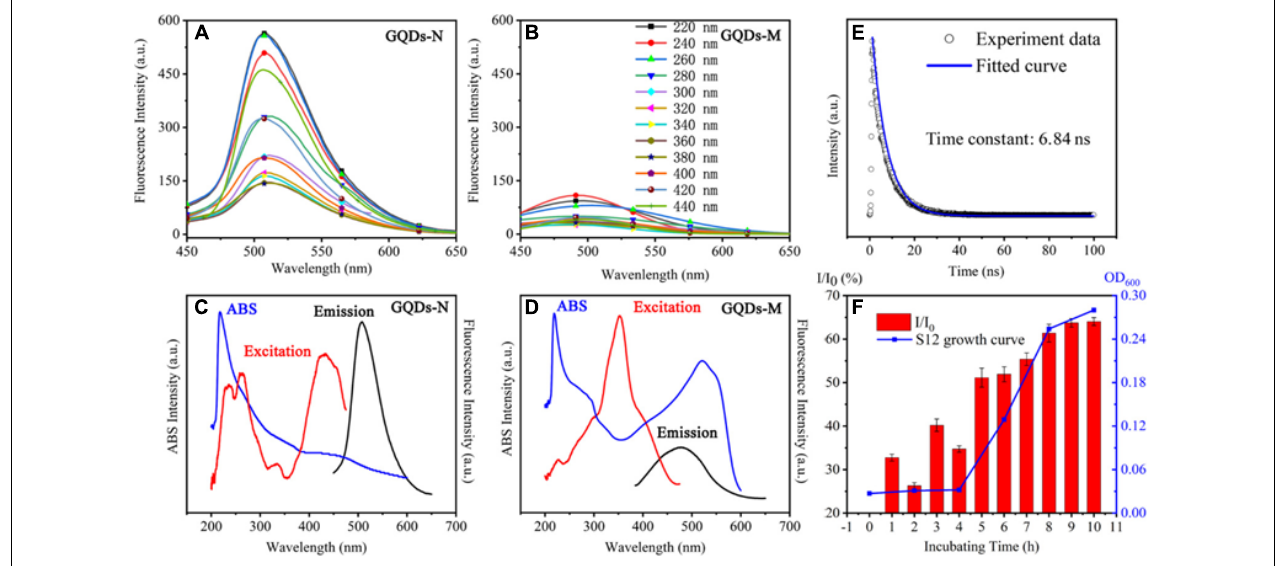
FIGURE 2 | Optical properties of functionalized GQDs. Fluorescent spectra of GQDs-N in panel (A) , GQDs-M in panel (B) . UV-visible absorption, emission, and excitation spectra of GQDs-N in panel (C) , and GQDs-M in panel (D) . Time-resolved fluorescence spectrum of GQDs-N in panel (E) . Changes in the fluorescence intensity I / I 0 at 520 nm as a function of time of GQDs-M1 incubation with strain S12 (1–10 h). I represents the fluorescence intensity of GQDs-M and I 0 indicates the fluorescence intensity of GQDs-N in panel (F)